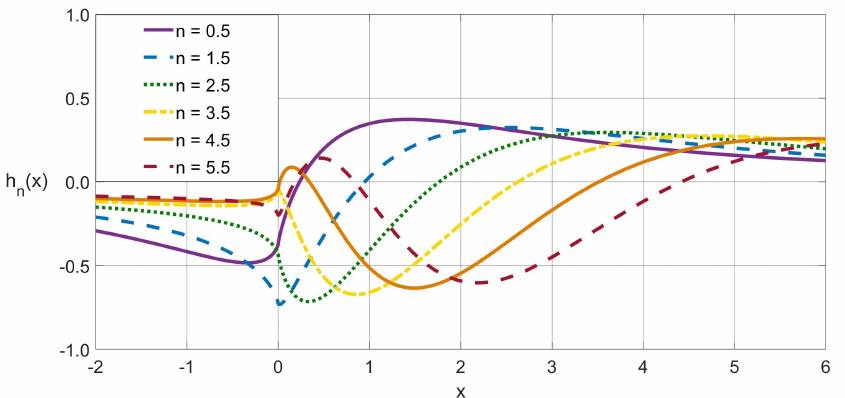
Figure 6. Bateman functions with negative n + 1/2 orders as a function of argument x .